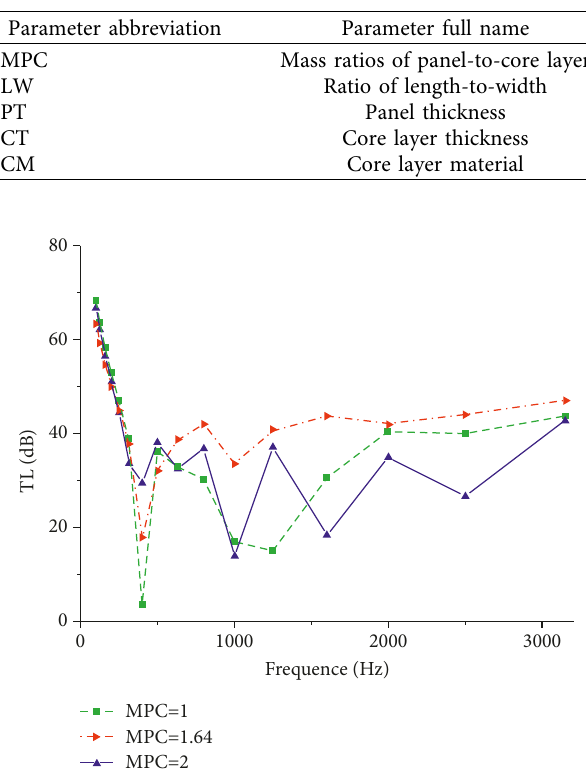
Figure 9: Influence of different panel-to-core layer mass ratios on sound insulation curve of SPS.